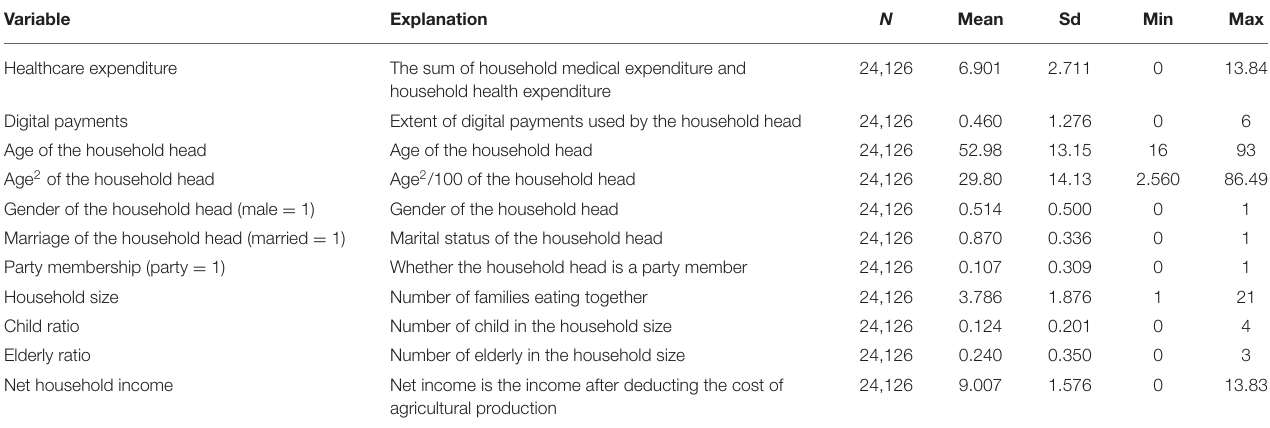
TABLE 1 | Statistical description of variables.